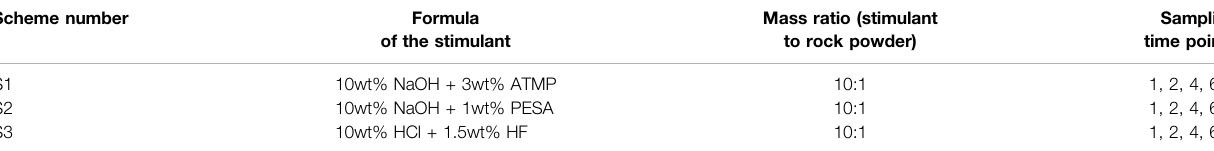
TABLE 2 | Schemes of the high-temperature and high-pressure static corrosion experiment. Scheme